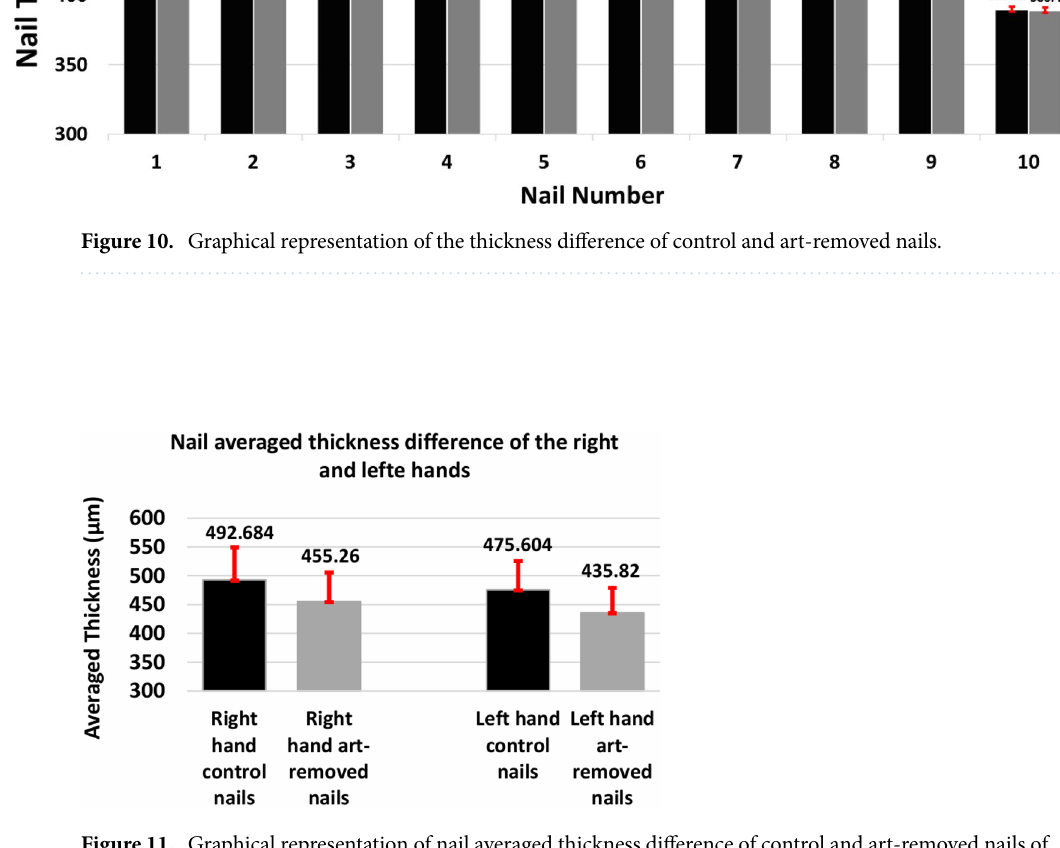
Figure 11. Graphical representation of nail averaged thickness difference of control and art-removed nails of the right and left